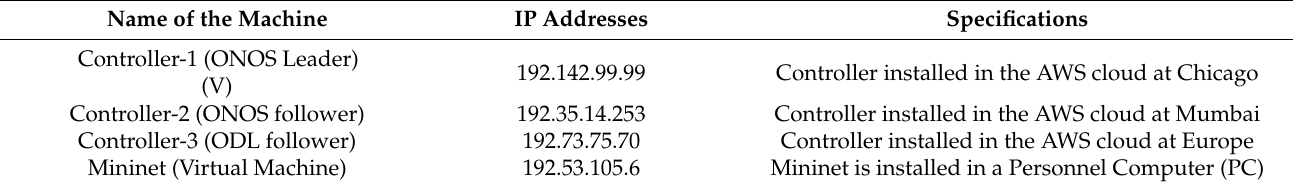
Table 2. A variety of machine